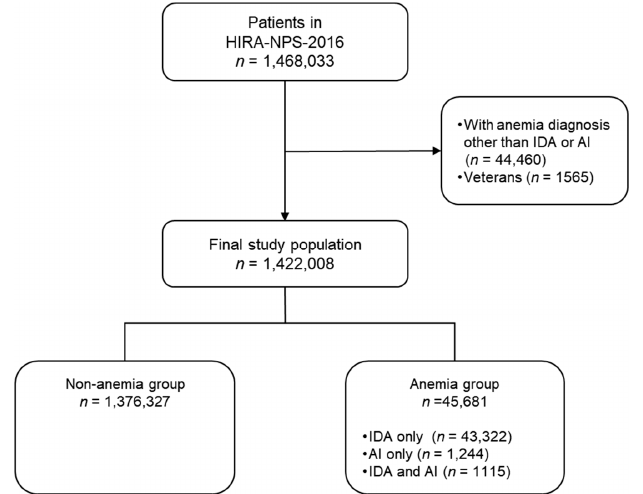
Figure 1. Flow diagram from study subject inclusion. HIRA: Health Insurance Review Agency, IDA: Iron deficiency anemia, AL: Anemia of inflammation.